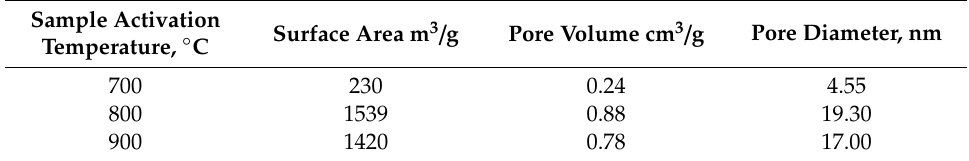
Table 1. Surface area and pore characteristics of graphene-based carbon aerogels activated at 700, 800, and 900 °C.